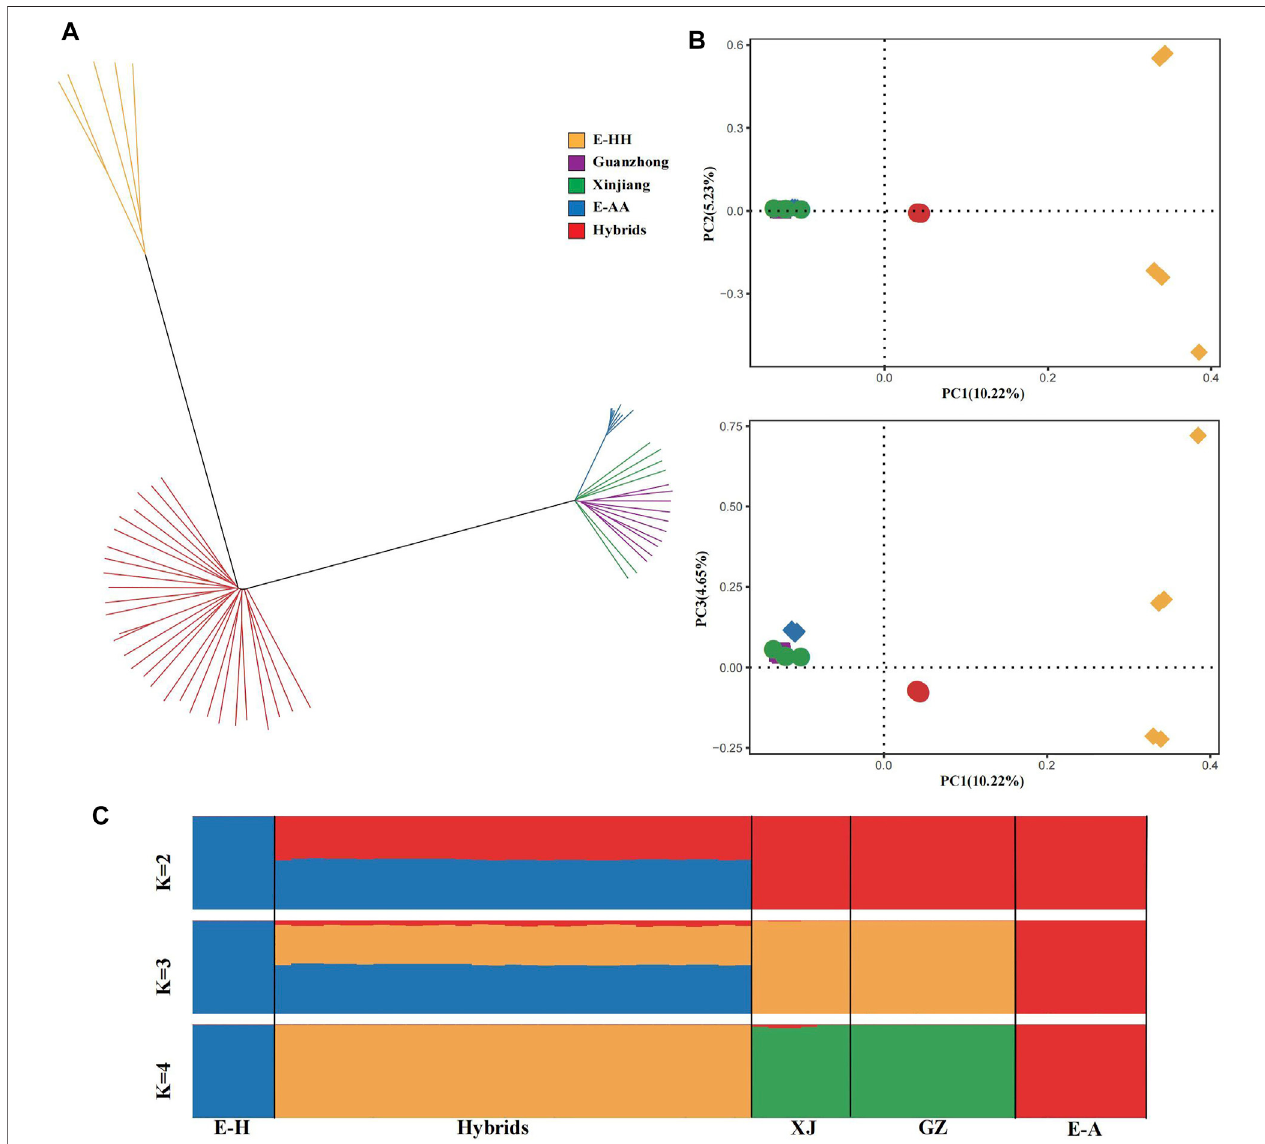
FIGURE 1 | The genetic structure of the donkey populations. (A) Neighbor-joining tree of the phylogenetic relationships identi fi ed among 58 donkeys analyzed, distributed as 8 E-AA in blue (Africa wild ass, Equus-asinus-africanus ), 10 Guanzhong in purple (Chinese donkey breed), 6 Xinjiang in green (Chinese donkey breed), 5 E-HH in yellow (Asiatic wild ass, Equus-hemionus ), 29 Kulan hybrids in red (Mongolian Kulan _ ×Xinjiang \ ). (B) Principal Component Analysis of 5 donkey breeds. (C) Bayesian model-based clustering (from K = 2 to K = 4) of 58 donkeys.